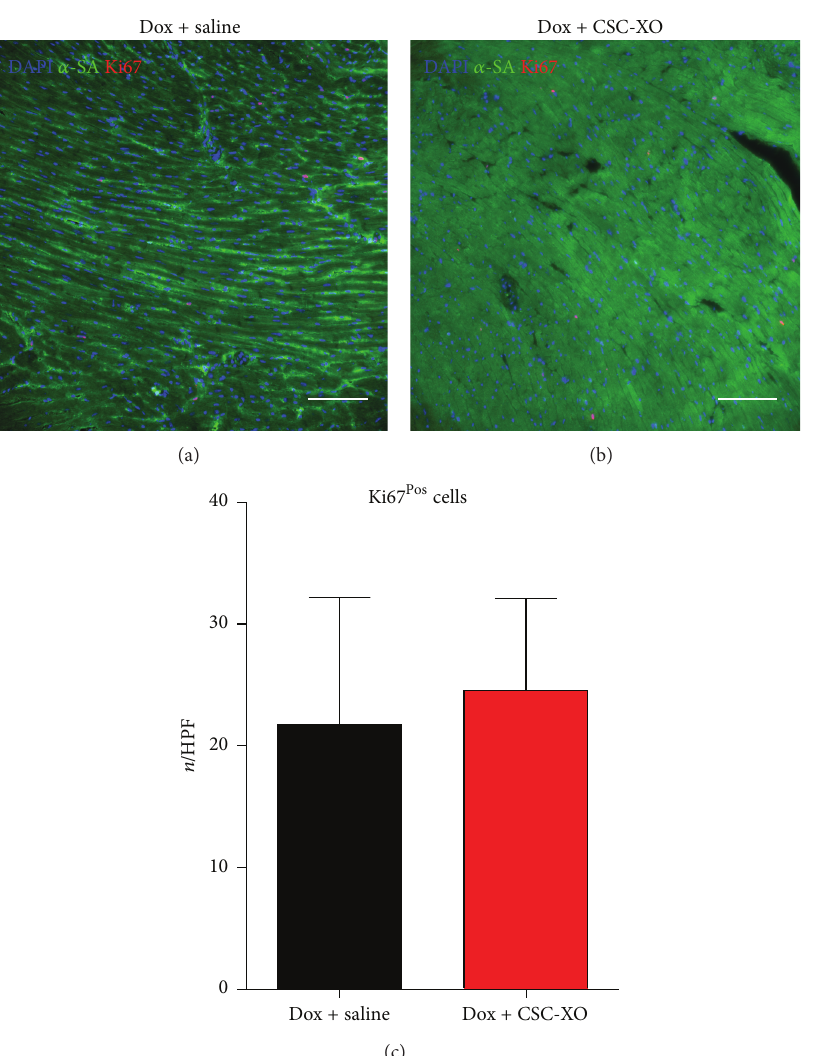
Figure 6: Cellular proliferation as indicated by Ki67 Pos cells for specimens receiving saline (a) or CSC-XO (b) shows no significant changes in number of positive cells per field of view (c). Scale = 100 𝜇